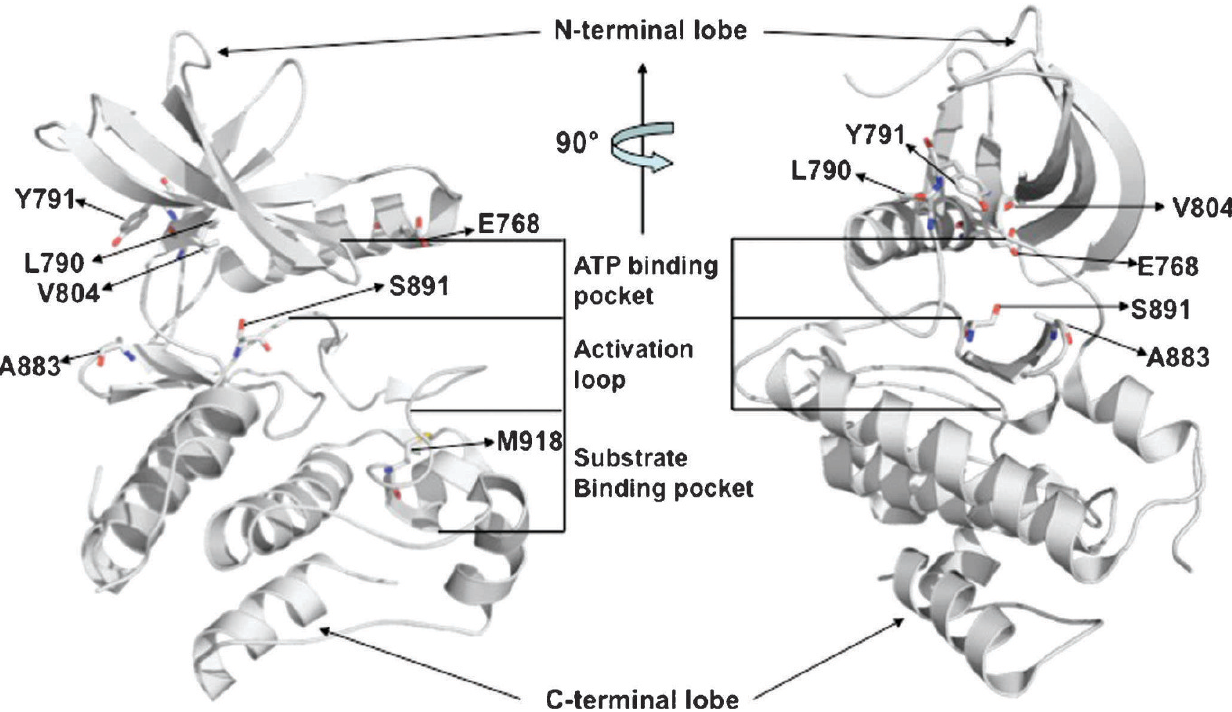
Figure 3 - Structure of the RET tyrosine kinase domain. Ribbon diagrams of the intracellular regions of activated RET, in two orientations, showing the positions of key functional features of the kinase: the ATP binding pocket; the activation or autoinhibitory loop; and the substrate binding pocket. Two orientations of the model, displaying the autoinhibitory/substrate binding face (left) and the ATP-binding face (right), are shown. Amino acid residues that are mutated in patients with multiple endocrine neoplasia type 2 (MEN 2) are represented in the stick form. The three-dimensional representation was based on the crystal structure of the phosphorylated (activated) RET tyrosine kinase domain